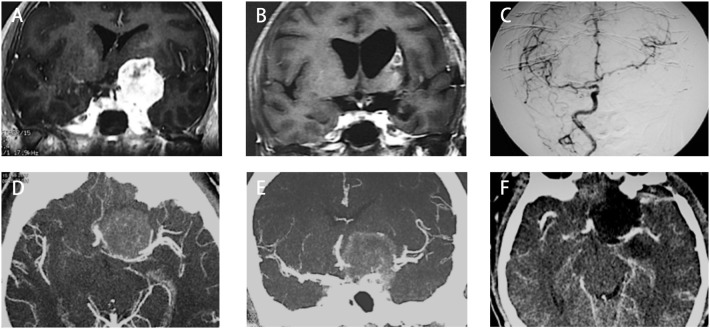
Two cases with anterior clinoidal meningiomas (ACMs) that experienced intraoperative rupture of internal carotid artery (ICA). (A) Preoperative coronal MRI showed a type I ACM, which involved the supraclinoidal part of the left ICA. (B) Postoperative coronal MRI showed gross-total resection of tumor, with a small infarction near the left side lateral ventricle, indicating the occlusion of perforators supplying the head of the caudle nuclei. (C) Postoperative angiography showed complete occlusion of the left ICA. (D,E) Preoperative CT angiography showed a type III ACM, which engulfs the bifurcation of the left ICA. (F) Postoperative CT angiography showed patent branches of the ICA with gross total removal of the tumor.